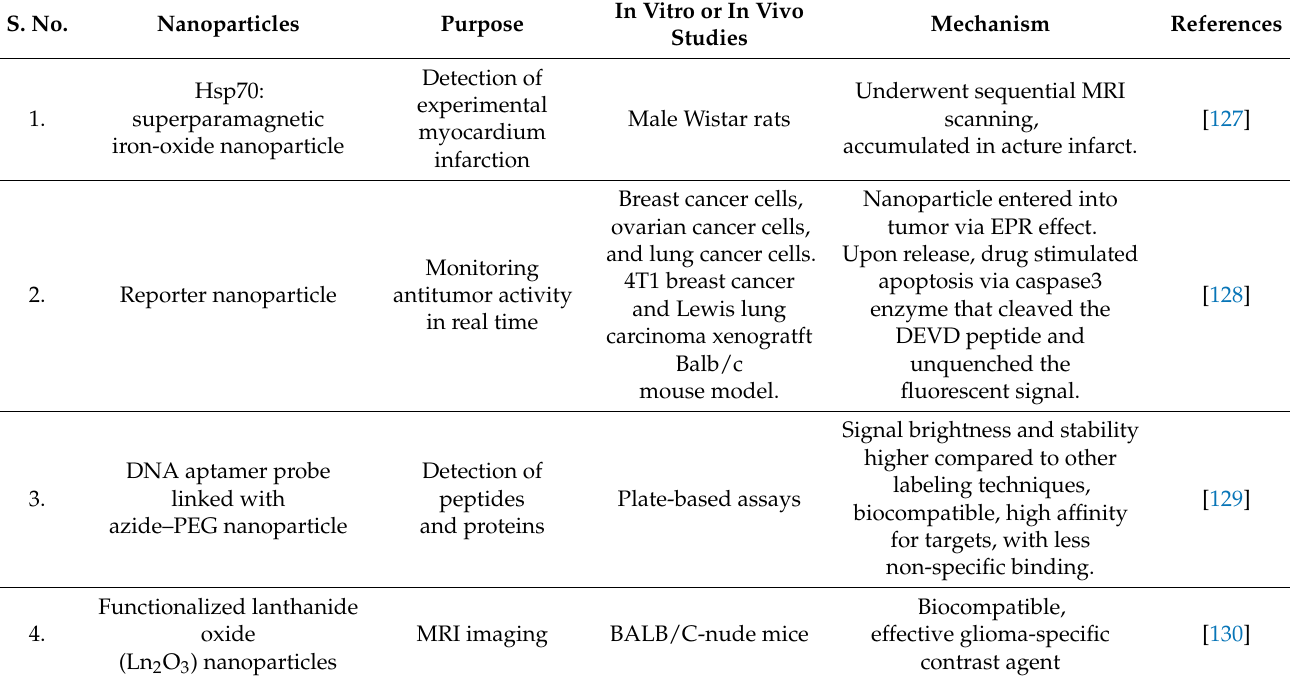
Table 2. Nanoparticles in